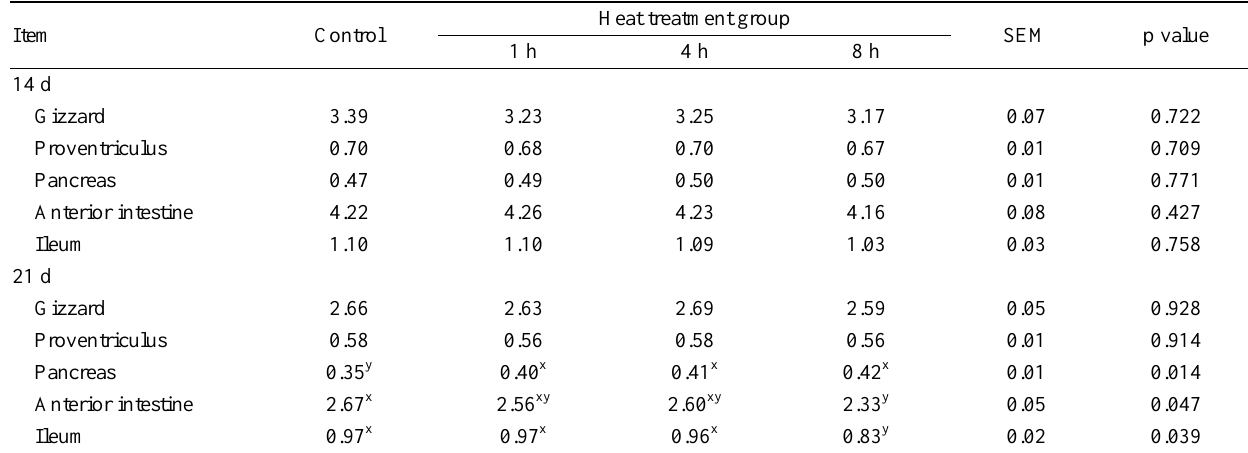
Table 4. Effects of heat-oxidized soy protein isolate on relative weight of digestive organs (g/100 g body weight) of